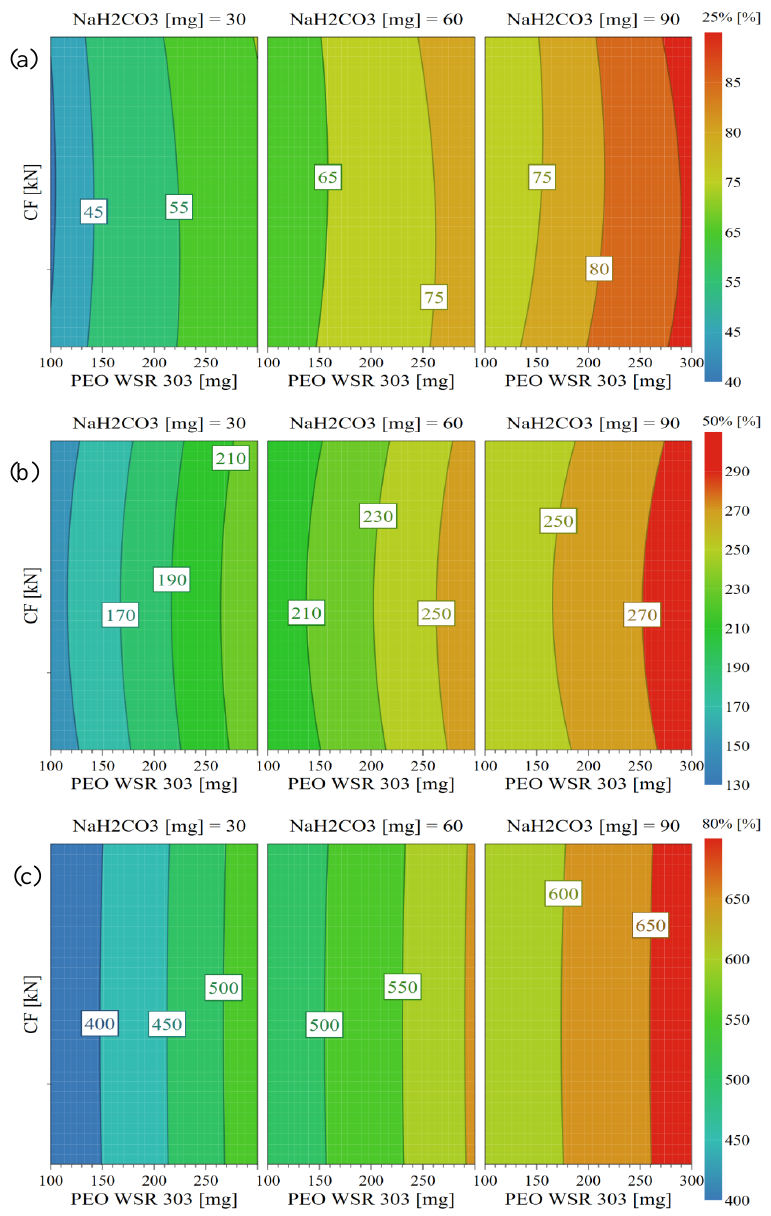
Figure 6. Figure 6. Contour plots showing the effects of hydrophilic polymer (PEO) and sodium bicarbonate on the drug release responses ( Y 1 –Y 3 ): ( a ) T25% ( Y 1 ), ( b ) T50% ( Y 2 ), and ( c ) T80% ( Y 3